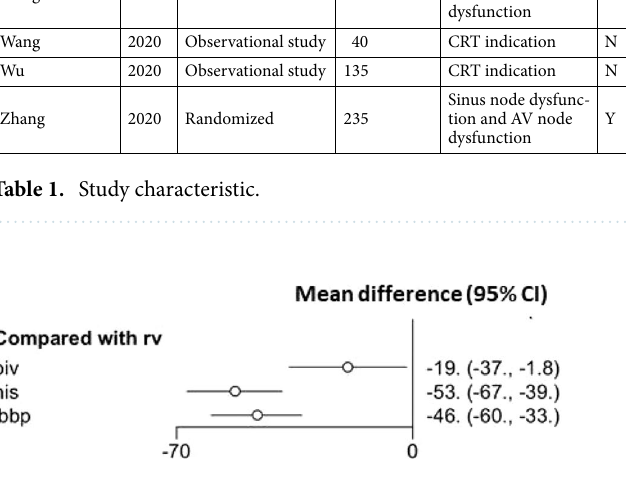
Figure 2. Forrest plot demonstrating relative effect size (QRS duration change pre implantation and post implantation) compared Pacing types with conventional RV apical pacing. Circle data markers represent mean difference of QRS duration between types of pacing compare to RV apical pacing, and horizontal lines represent 95% confident interval (CIs).